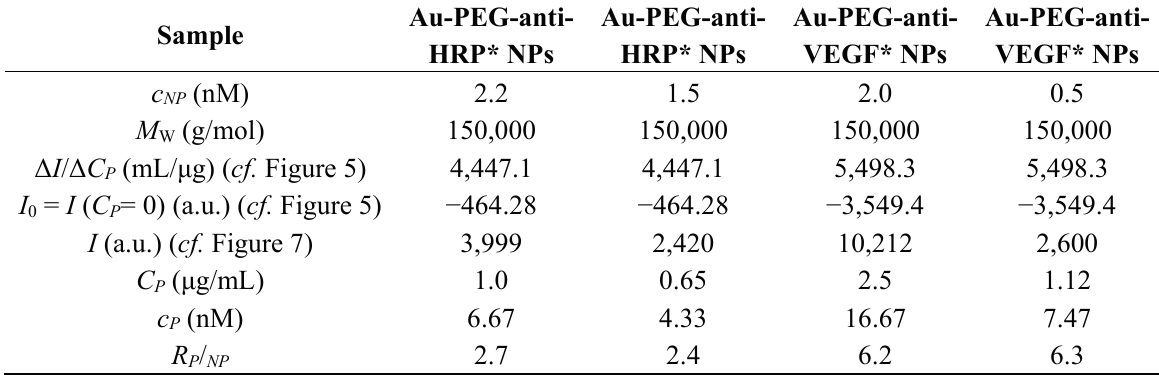
Table 1. Summary of the calculations for the amount of proteins per nanoparticles (NP). Au-PEG-anti- Au-PEG-anti- Au-PEG-anti- Sample HRP* NPs HRP* NPs VEGF* NPs